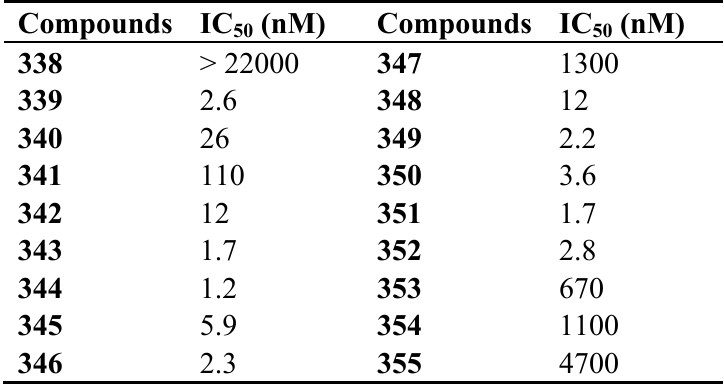
Table 25. Summary of the inhibitory potencies against complex I.